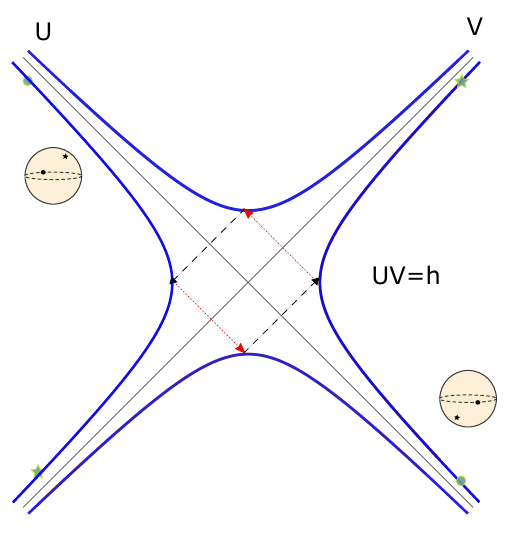
Figure 5 . The near horizon local CPT identification proposed in [13]. We use the double sided Penrose diagram only to describe the near horizon region (pink region of figure 2) and we perform the identification up to the hyperbolae that are at a Planckian distance from the horizon, as in [13]. feature of Planckian sized black holes, for which ~ G/R 2 ∼ O (1) , but it is also